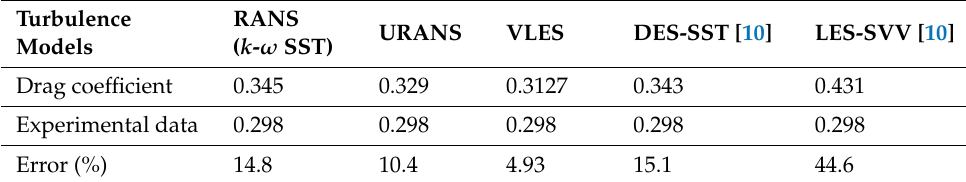
Table 3. Drag coefficients by RANS, URANS, VLES, DES and LES and their comparison with ex- perimental data.